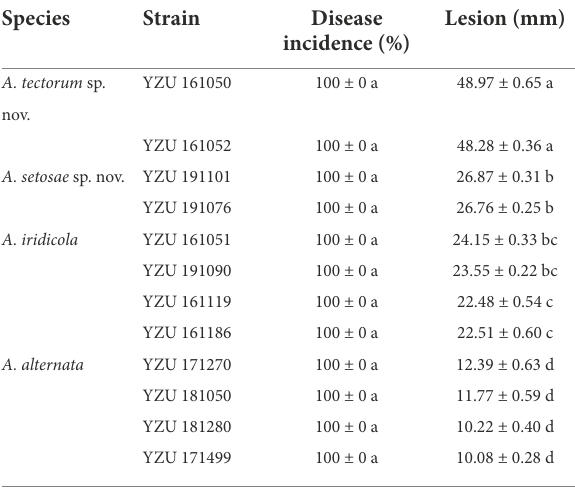
TABLE 4 Disease incidence and lesion size on Iris setosa induced by the present Alternaria species. Species Strain Disease Lesion (mm) incidence (%)